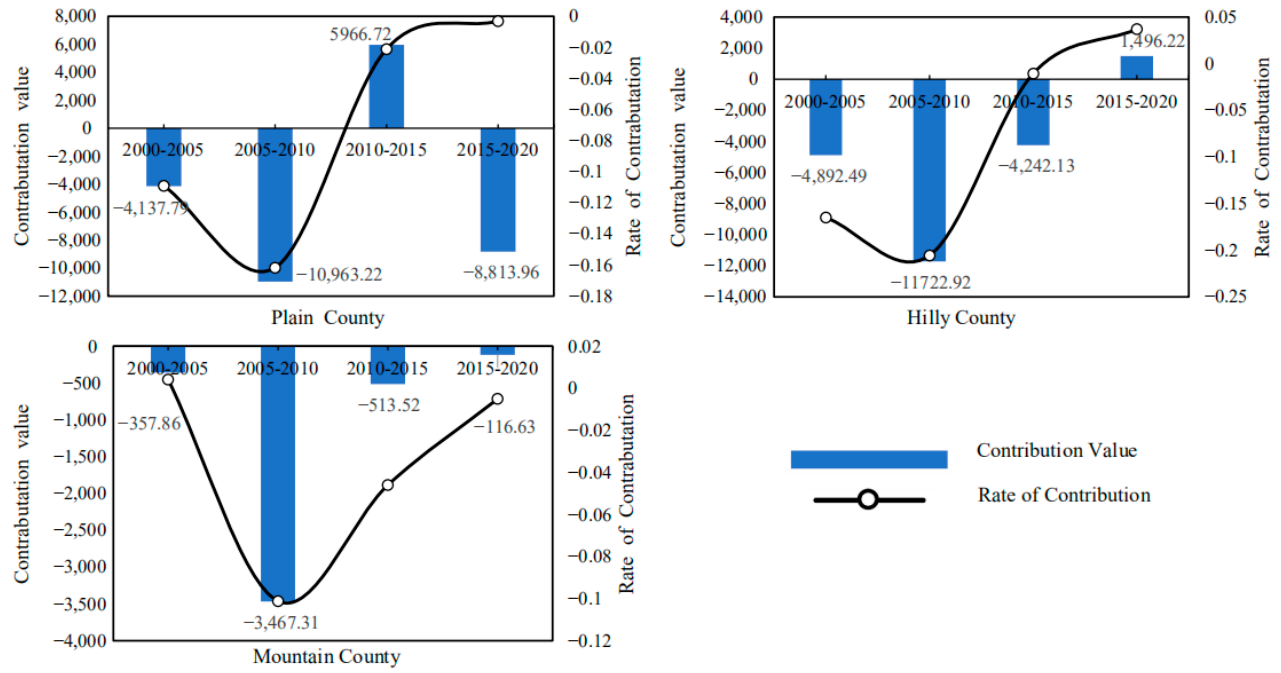
Figure 12. Topographic heterogeneity of emission reduction effect of agricultural production structure (including Plain County, Hilly County, Mountain County).